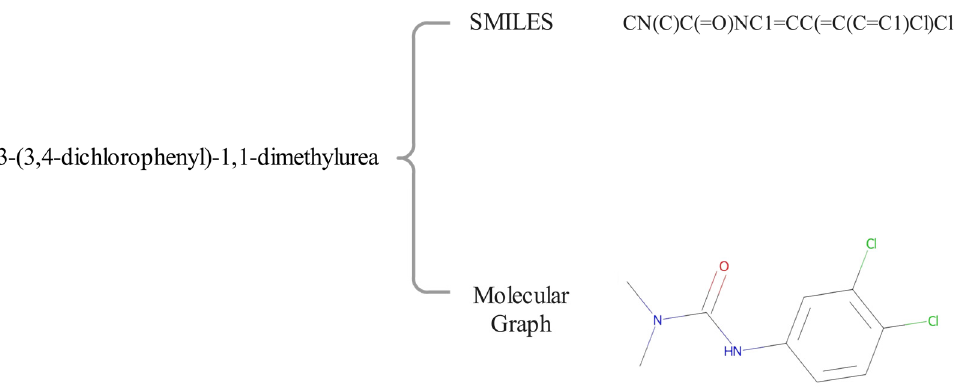
Figure 1. Two representation methods of the same molecule, namely SMILES and molecular